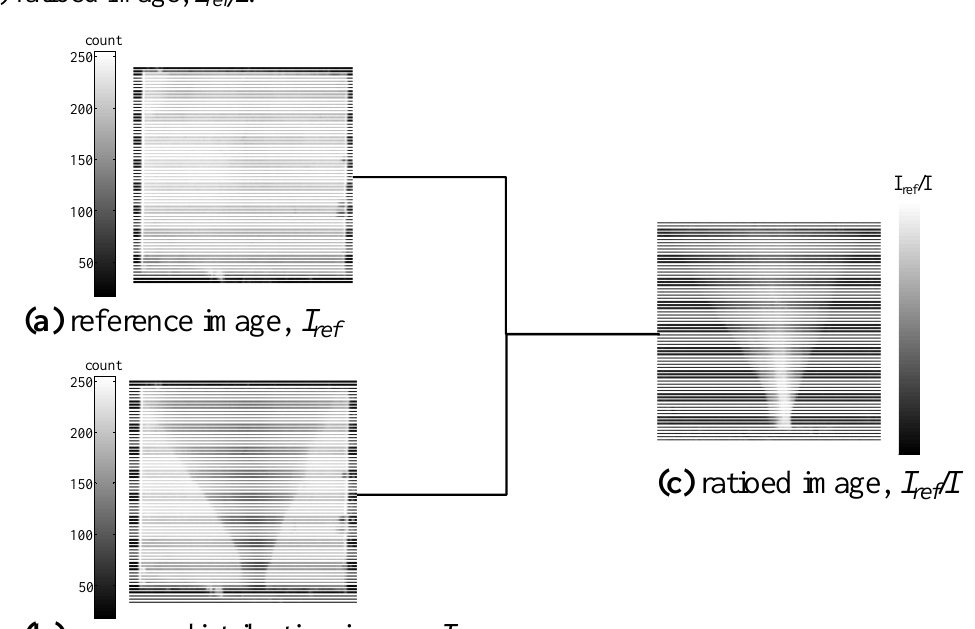
Figure 12. (a) Reference image, I (c) ratioed image, I